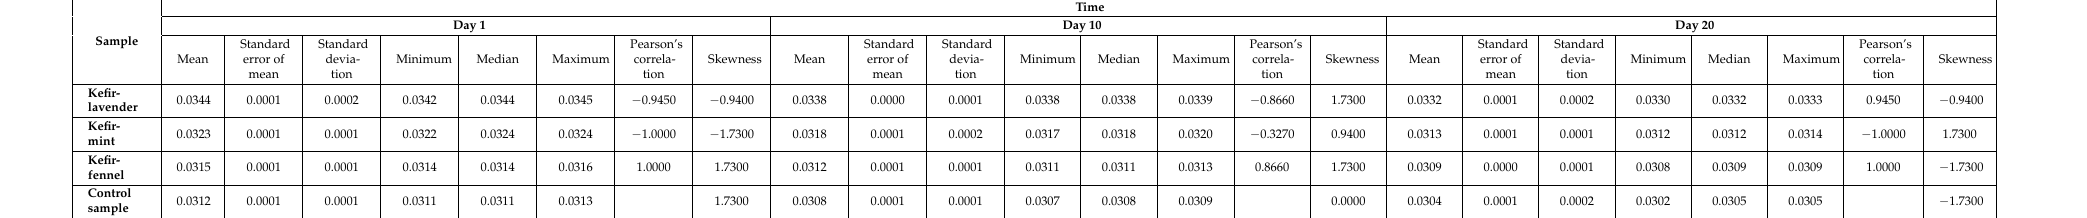
Table A3. Determination of D-glucose